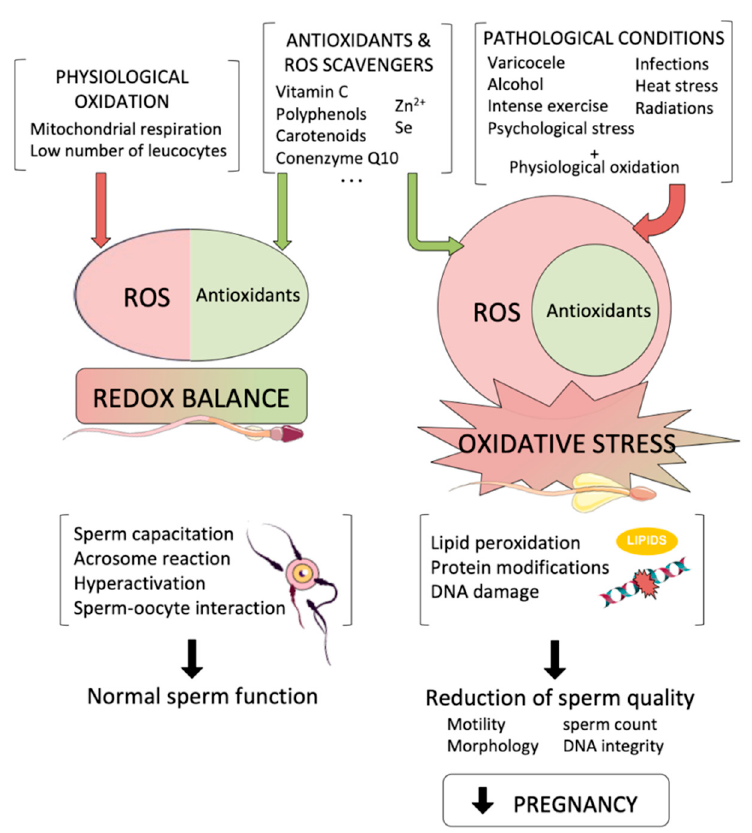
Figure 1. Reactive oxygen species (ROS) are by-products that are necessary for essential sperm functions. On the left, a redox balance is achieved when physiological oxidation is compensated by antioxidants, so that physiological oxidation allows sperm to perform their normal functions. However, when pathological conditions lead to an increase in intracellular ROS levels (right), oxidative stress affects sperm cells causing a reduction in sperm quality that leads to a reduction in pregnancy